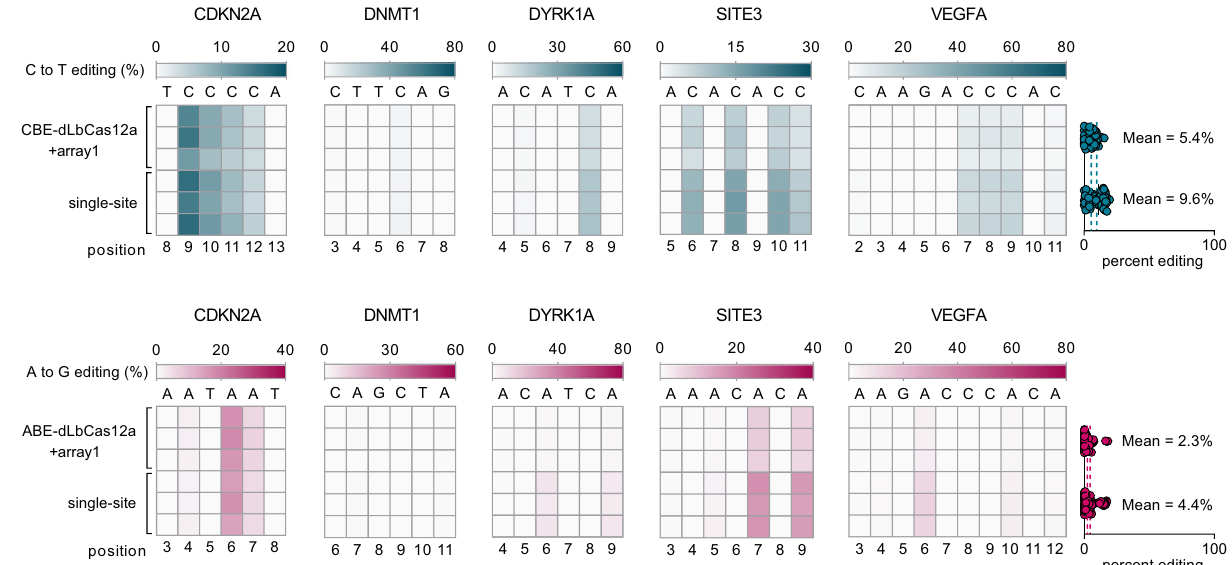
Fig. 1 Cas12a multiplex strategy for MBE. Heat maps show 3 independent biological replicates at each condition, counting the most PAM-distal position as 1. The dashed line in scatters dot plots shows the mean value of all desired BE ef fi ciencies within the displayed activity windows of each site. Single-site, using CBE-dCas12a or ABE-dCas12a with the relevant hU6-driven gRNA for single-site base editing. Detailed constructs of CBE-dCas12a (2xUGI- rAPOBEC1-dCas12a) and ABE-dCas12a (TadA-8e-dCas12a) are available in Supplementary Table 1. Protospacer and amplicon information can be found in Supplementary Table